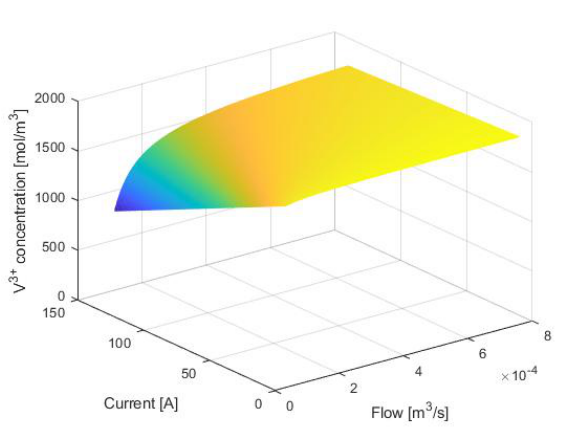
Figure 3. Equilibrium points of V 3 + for a 10% of